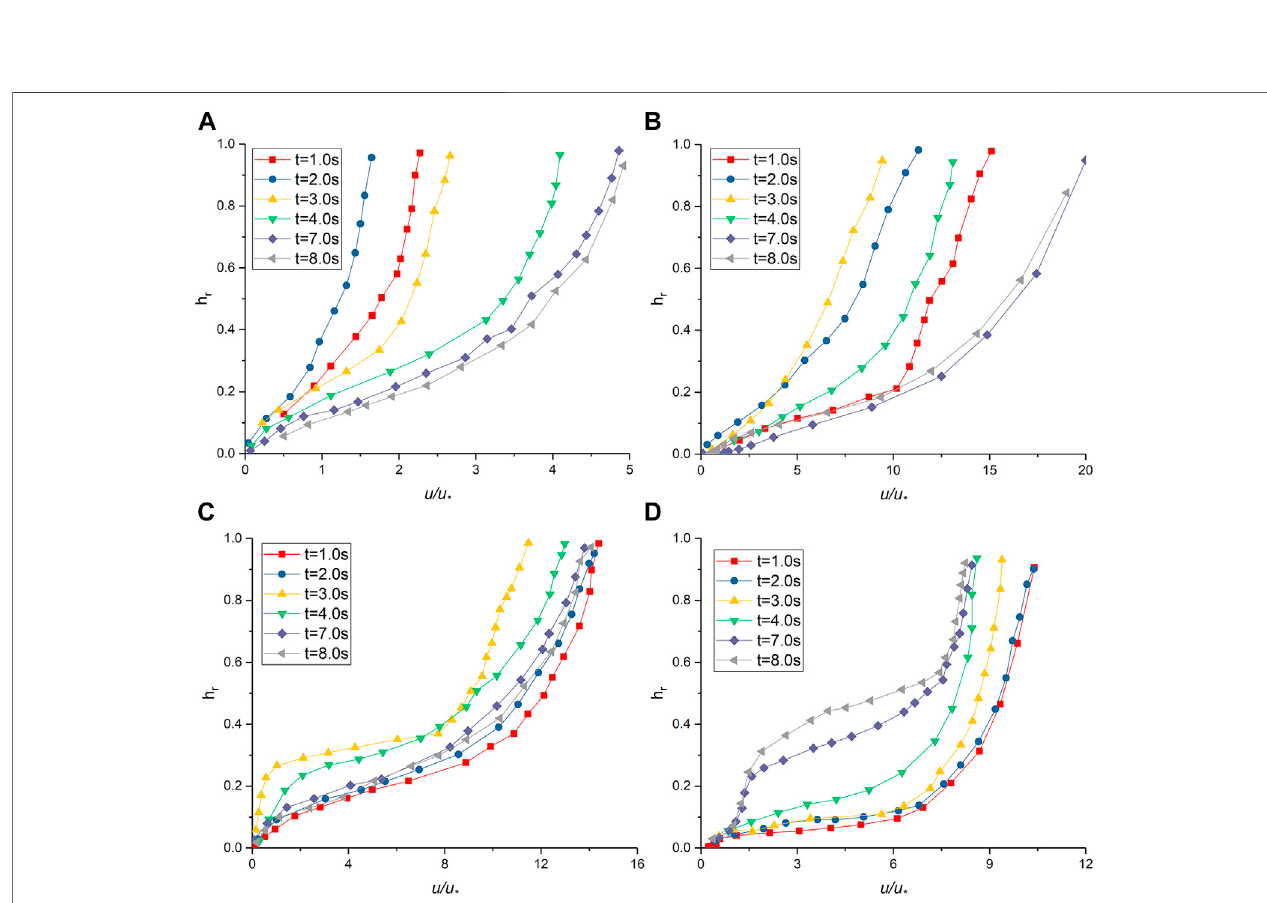
FIGURE 9 | Fluid velocity pro fi le, gravity erosion: (A) CS1; (B) CS2; (C) CS3; (D) CS4.